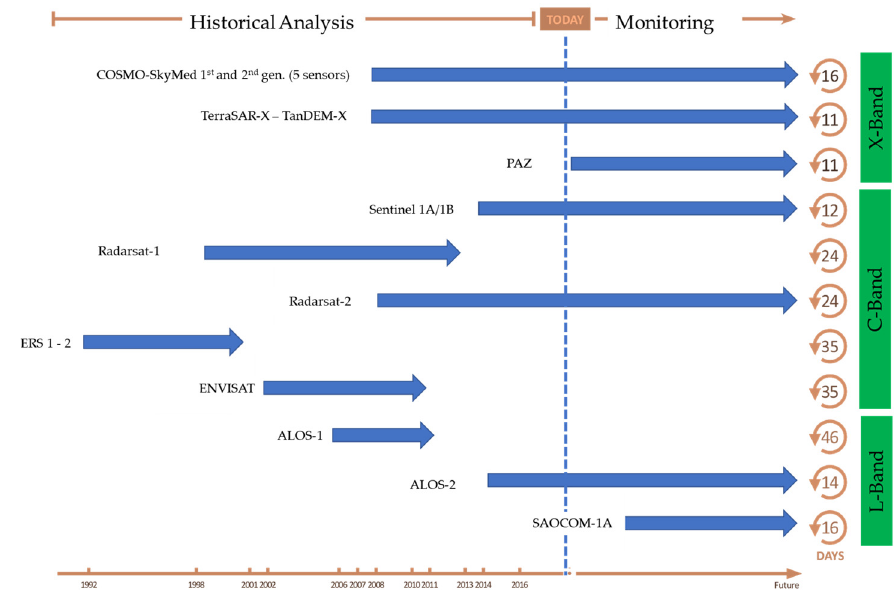
Figure 9. Overview of the SAR satellite missions taking place from 1992 to 2022. ASI’s COSMO-SkyMed Mission: Overview and Current Status